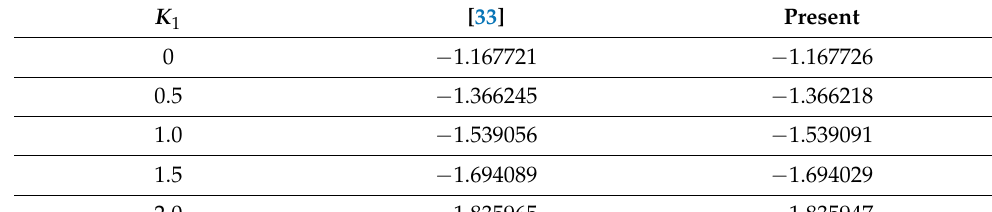
Table 2. Comparative study for dimensionless stress.